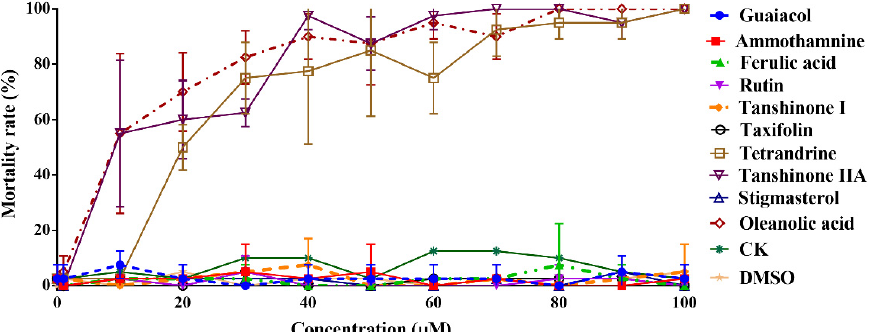
Figure 1. Medicinal toxicity was analyzed in vivo. Shrimp larvae were incubated with ten active small molecules of 0–100 µ M for 72 h, and the mortality rate was analyzed. Each value was represented as the mean ± SD.